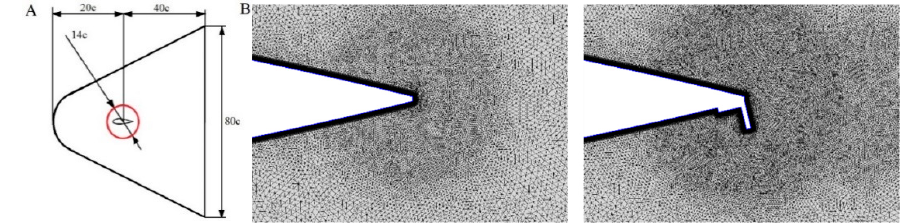
Figure 6. ( A ) Computational domain; ( B ) detailed view of the mesh at the trailing edge of the smooth airfoil ( left ) and near the GF ( right ).